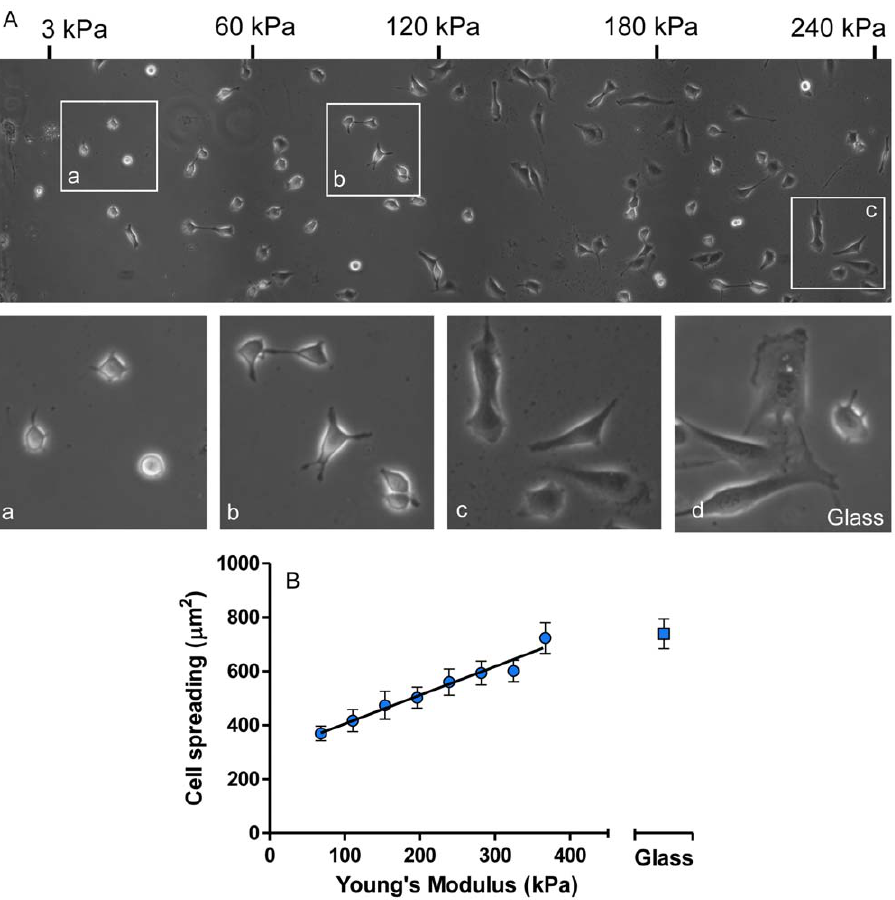
Figure 5. Spreading of cells correlates with hydrogel stiffness. (A) Phase contrast image of NIH3T3 fibroblasts on a stiffness gradient hydrogel functionalized with fibronectin. The hydrogel stiffness increases towards the right of the image. Numbers on the top indicate Young’s modulus values. Individual panels (a–c) qualitatively show that cell spreading increases with hydrogel stiffness. Panel (d) is an image of spreading cells on glass. (B) Quantitative analysis of cell spreading as a function of hydrogel stiffness. The spreading of cells attached to the stiffer part of the hydrogel, compared with the spreading of cells on glass. Error bars represent SE.